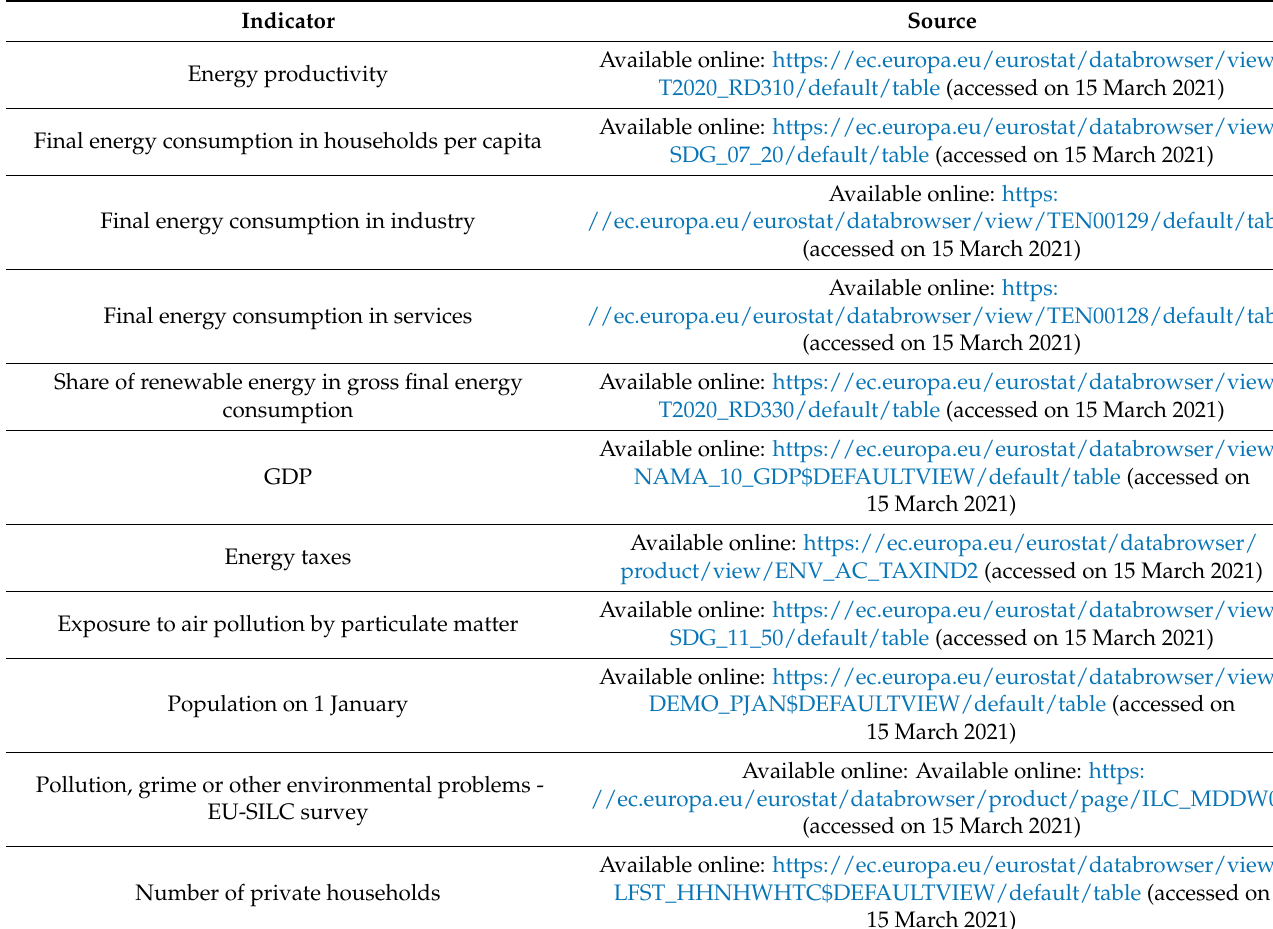
Table 1. Data definitions and